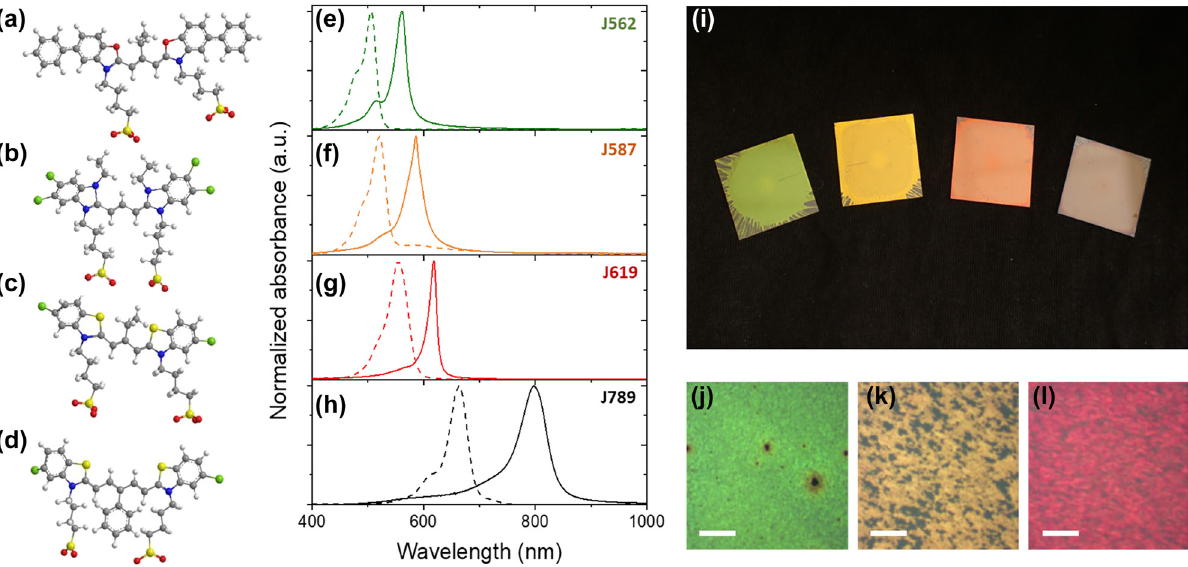
Figure 1: Bio-inspired polaritonic library. (a)–(d) Molecular structure of the monomers of the selected cyanine library for this work. They are named here according to the absorption peak of the J-aggregate conformation (chemical structures with higher resolution can be found in Figure S1). (e)–(h) Normalized absorbance of monomeric dye solutions in ethanol (doted lines, 100 μ M) and J-aggregate:PVA mixtures (solid line) for the J-aggregates (e) J652, (f) J587, (g) J619 and (h) J789. (i) Picture of the J-aggregate:PVA films on top of black cardboard. From left to the right: J562, J587, J619 and J789 films. Optical microscope images of a 250 μ m square area for dye (j) J562 (k) J587 and (l) J619 measured in reflectance microscopes under Köhler Illumination configuration. The scale bar is 50 μ